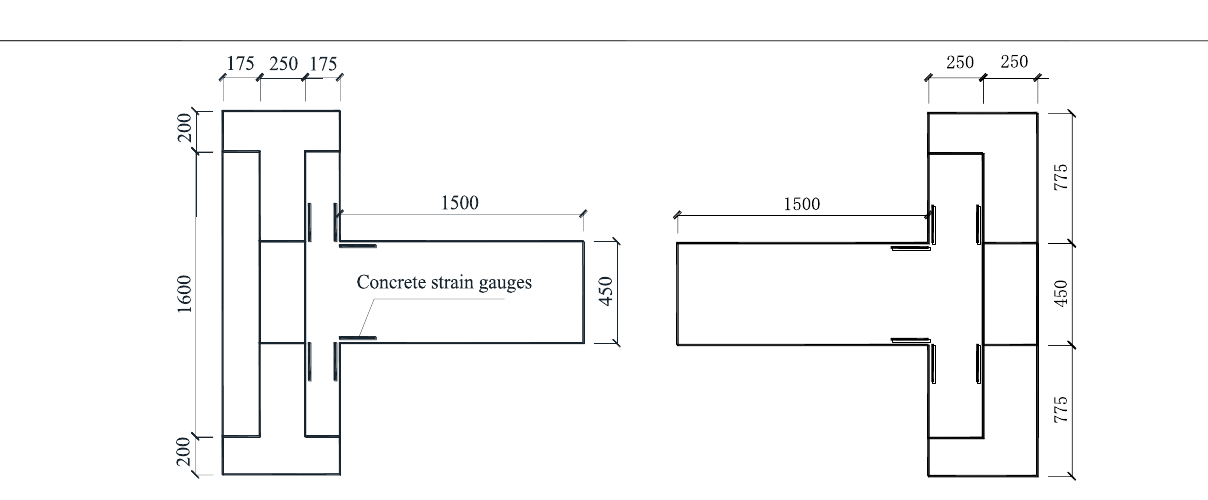
FIGURE 18 | Distribution of concrete strain gauges.